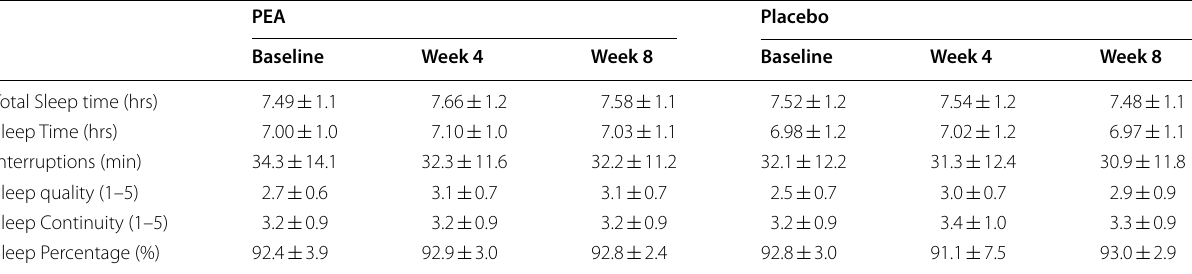
N.B. Data presented as mean (n 78); PEA =